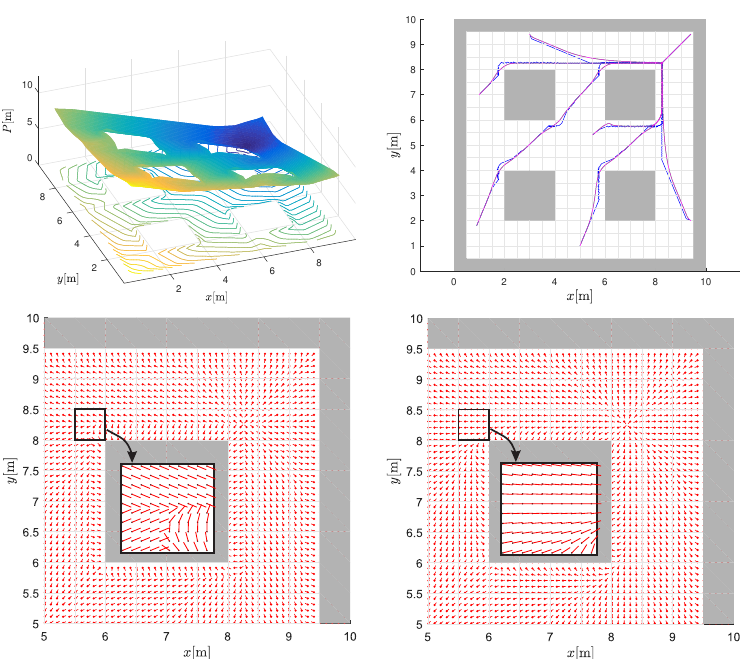
Figure 3. Interpolated potential surface P n ( x n , y n ) (CtG values, darker colours denote lower CtG values) obtained through bilinear interpolation with contours of equal potential, corresponding to the discrete CtG values of environment of Figure 1 ( top-left ). Obtained paths following the negative gradient (blue line) and interpolated negative gradient (purple line) are shown ( top-right ). Part of the environment near the goal with negative gradients (red lines going from black dots outwards) computed from (4) ( bottom-left ) and interpolated negative gradients ( bottom-right